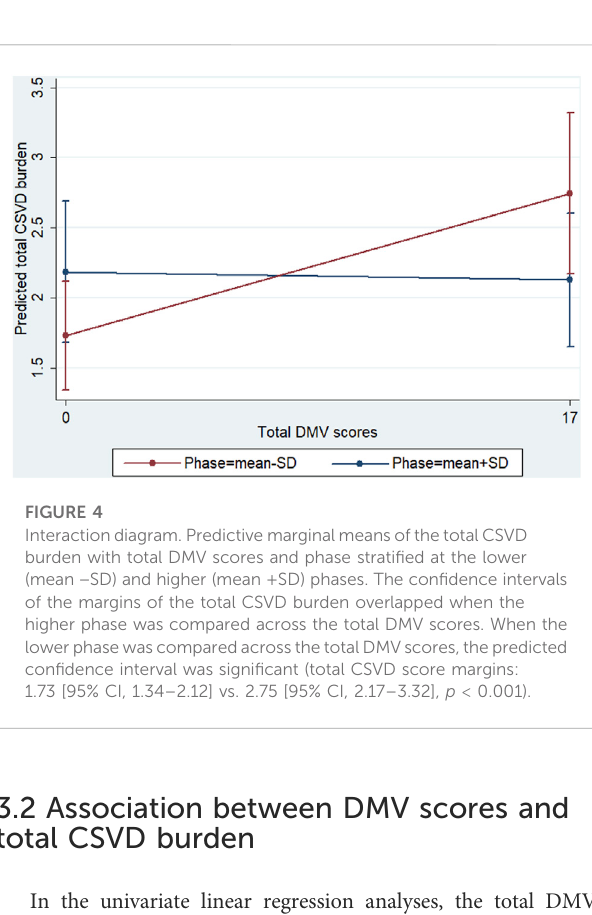
TABLE 2 Multivariate analysis of DMV scores and total CSVD burden/phase. Total DMV scores and DMV (left) and phase (left) DMV (right) and phase total CSVD burden